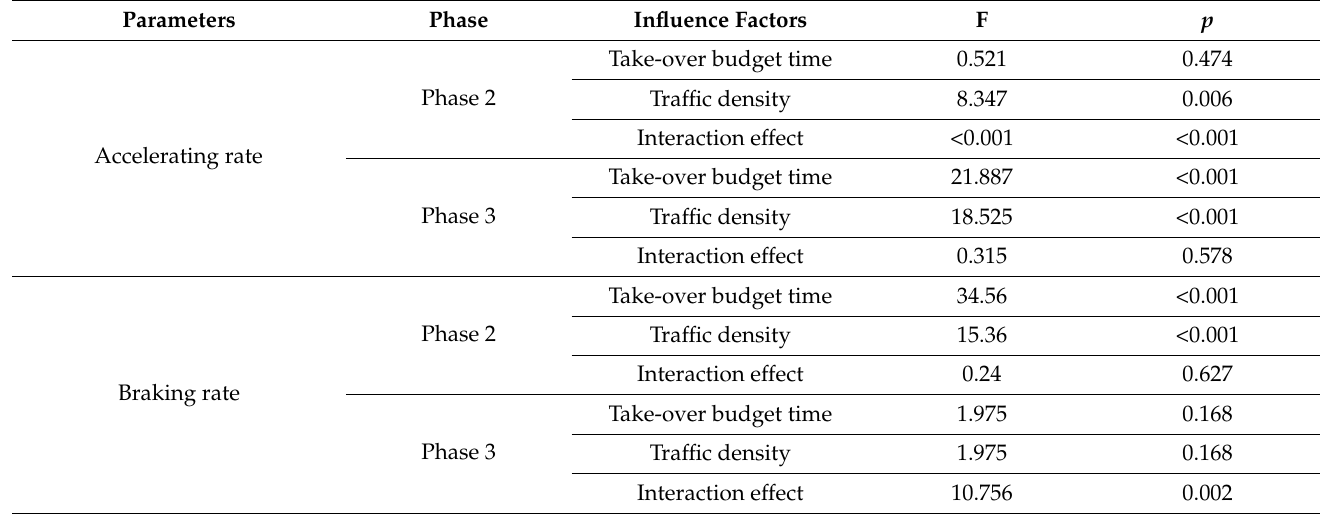
Table 5. Influence of take-over budget time and traffic density on longitudinal operation parameters.